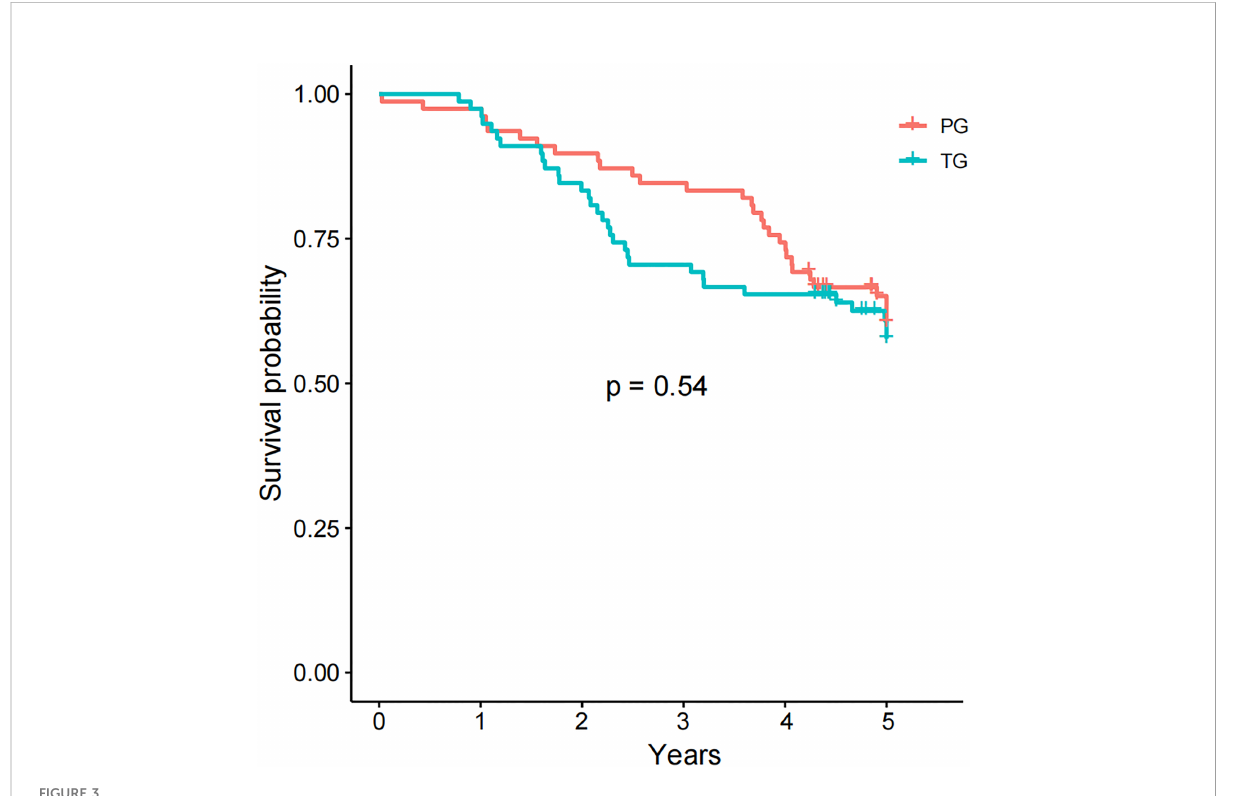
FIGURE 3 5-year overall survival in the PG and TG groups after